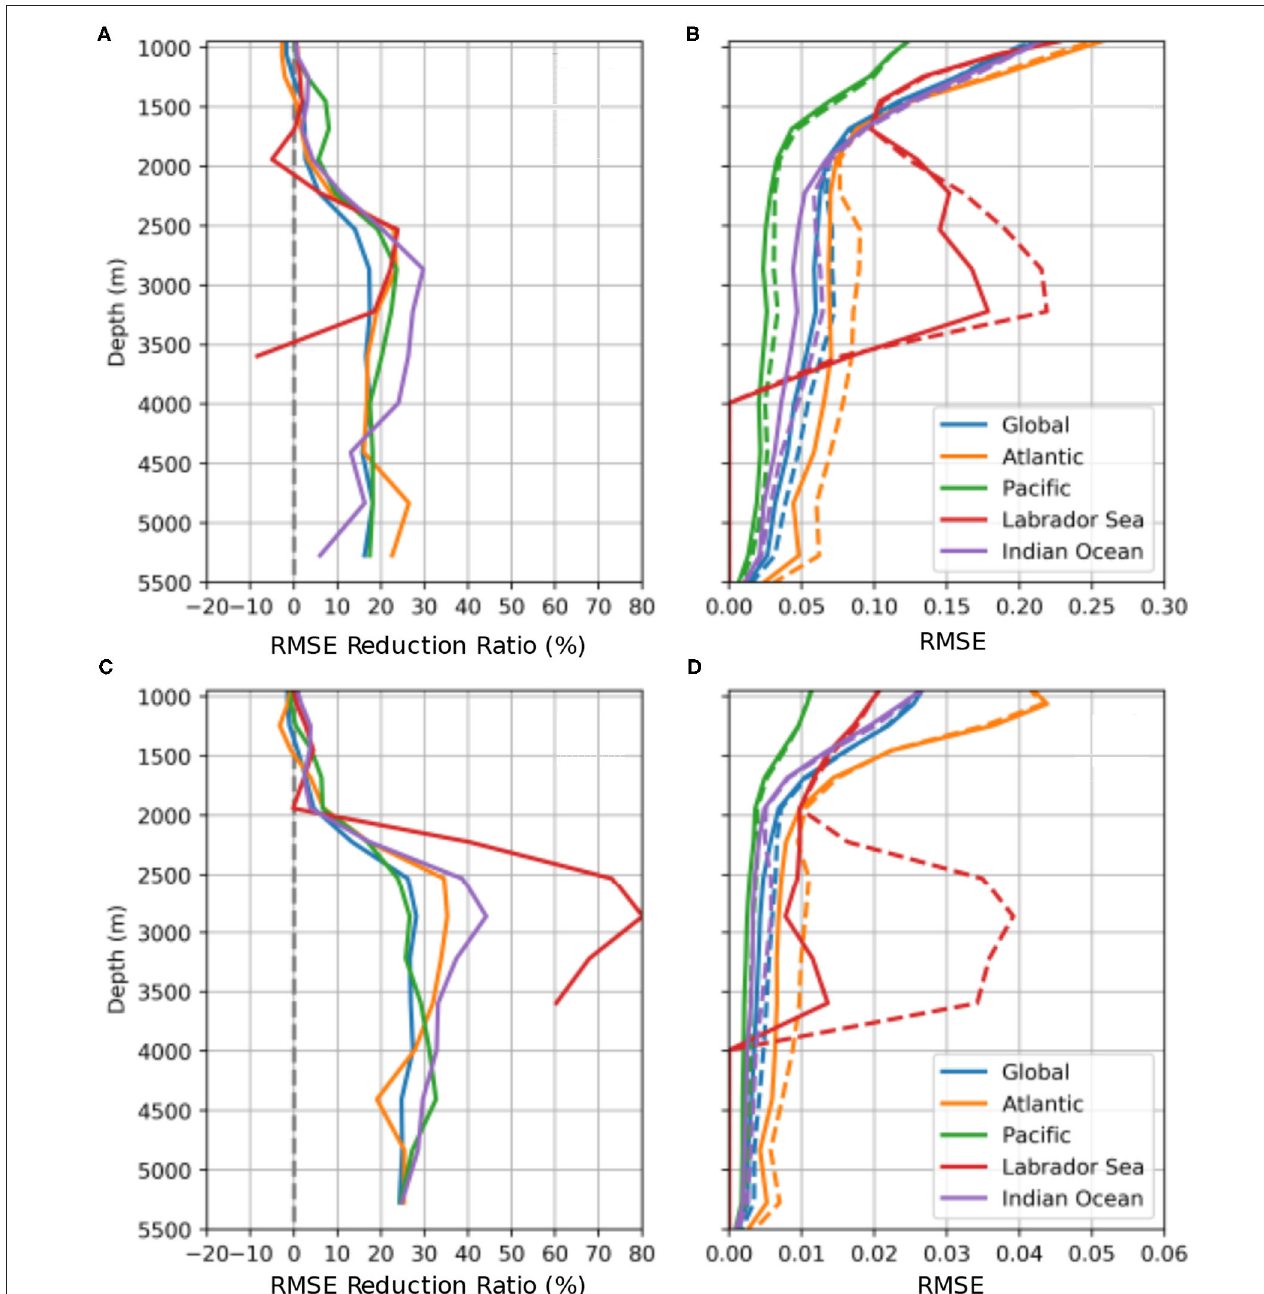
FIGURE 9 | RMSE reduction (as defined by equation3) and RMSE of DEEP-NR compared to Backbone-NR in five geographical regions: (A) temperature RMSE reduction, (B) temperature RMSE of DEEP (solid lines) and Backbone (dashed lines), (C) salinity RMSE reduction, and (D) salinity RMSE of DEEP (solid lines) and Backbone (dashed lines). Blue: Global, orange: Atlantic, green: Pacific, red: Labrador Sea and purple: Indian Ocean.